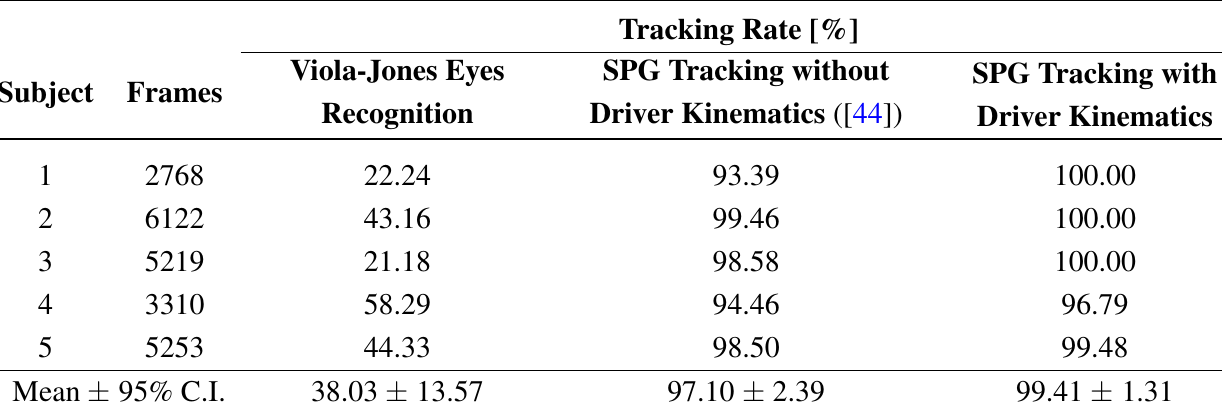
Table 1. Eye tracking results with the proposed